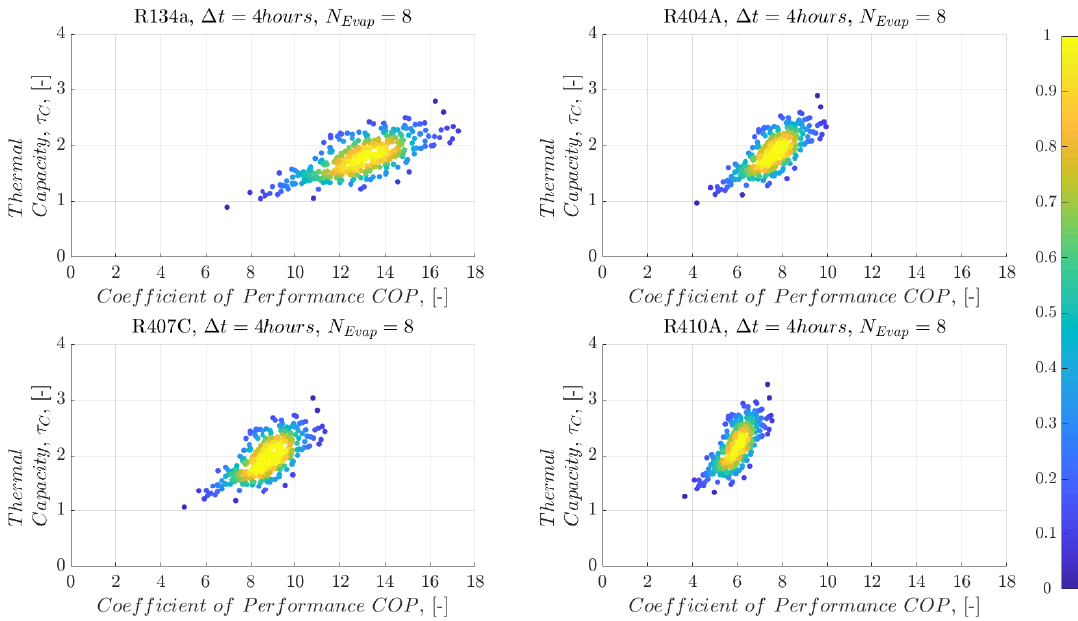
Figure 15. Probability density estimation of the relative efficiencies for all refrigerants and eight collectors.